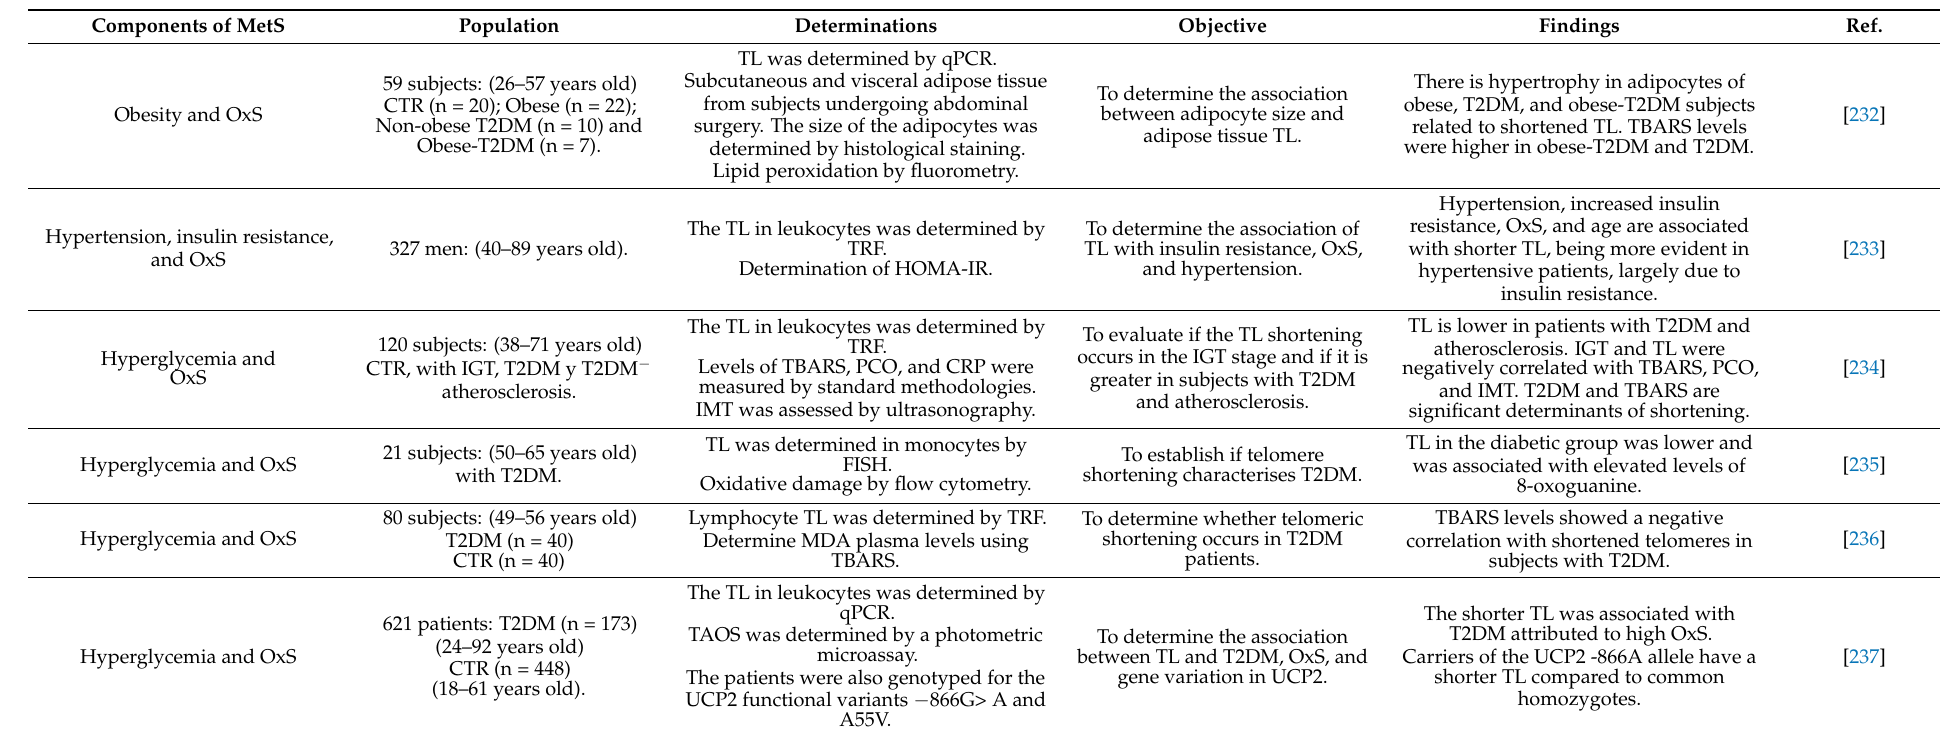
Table 2. Components of MetS and its association with telomeric length and